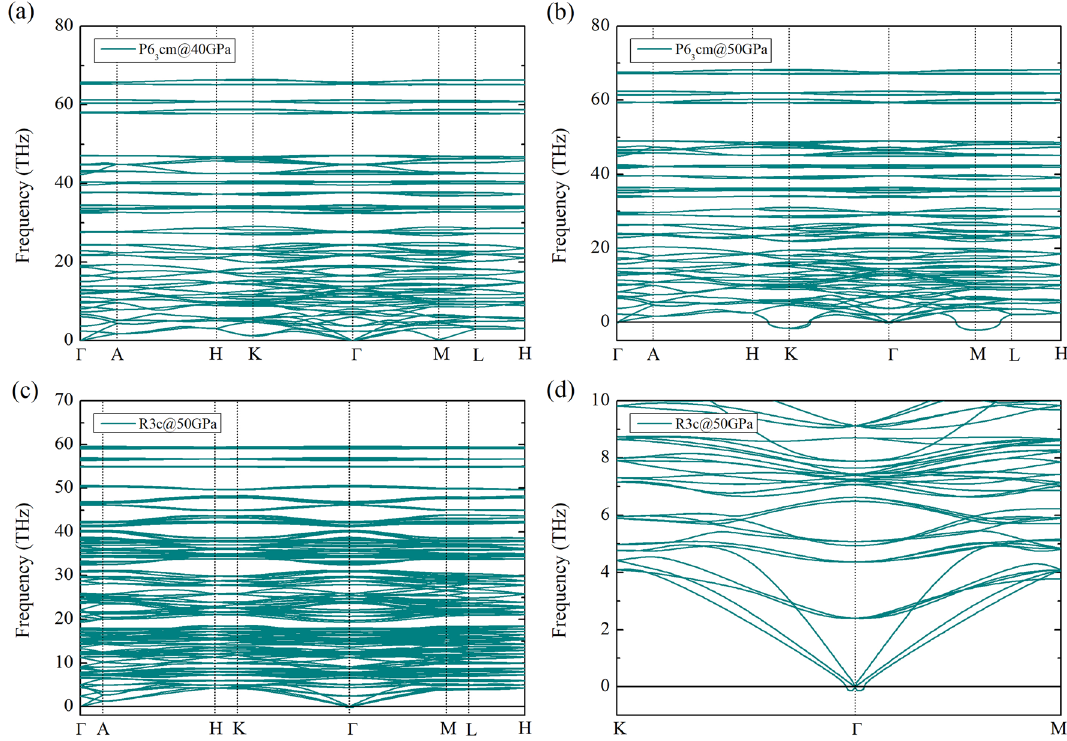
Figure 3. The phonon dispersion of Li 5 MoH 11 (a) P6 3 /cm at 40 GPa. (b) P6 3 /cm at 50 GPa (c) R 3 c at 50 GPa (d) soft-mode at the Ŵ –point of R 3 c at 50